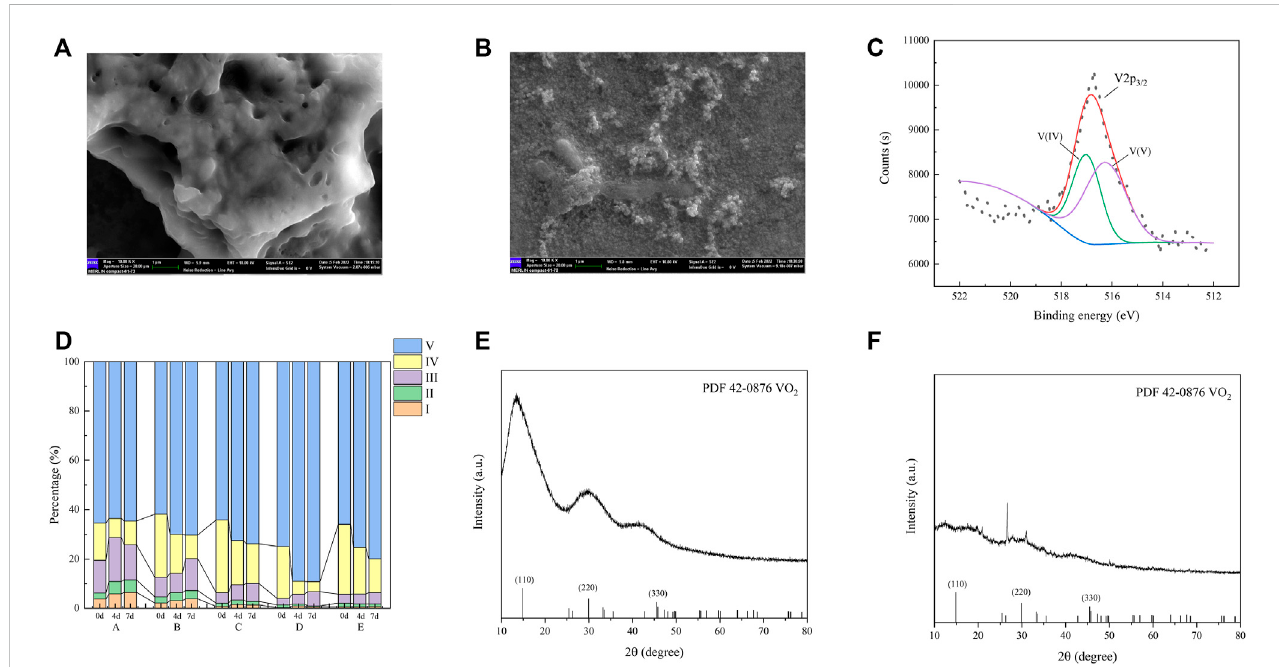
FIGURE 2 SEM images of WWR before (A) and after (B) use. XPS pattern of the precipitate in group D (100 mL WWR) (C) . Characterization of the dissolved organic matter by fl uorescence regional integration with various WWR dosages (D) . XRD pattern of the precipitate in reactors without (E) and with (F) inoculated